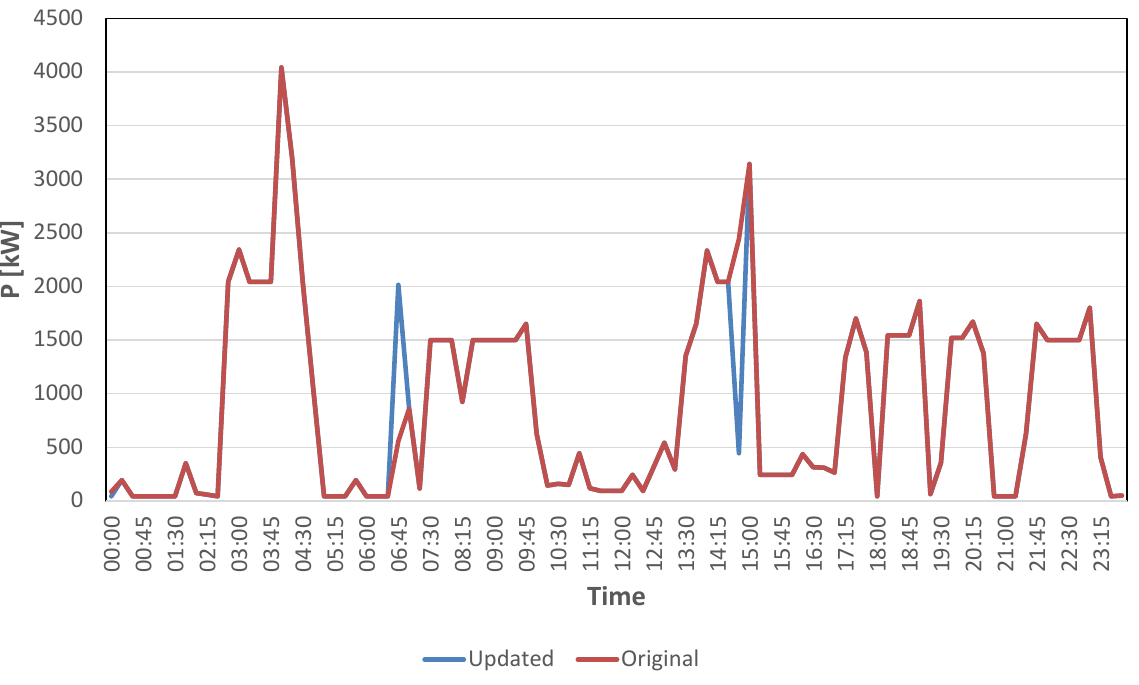
Table 2. Winner Offer at 14.45.